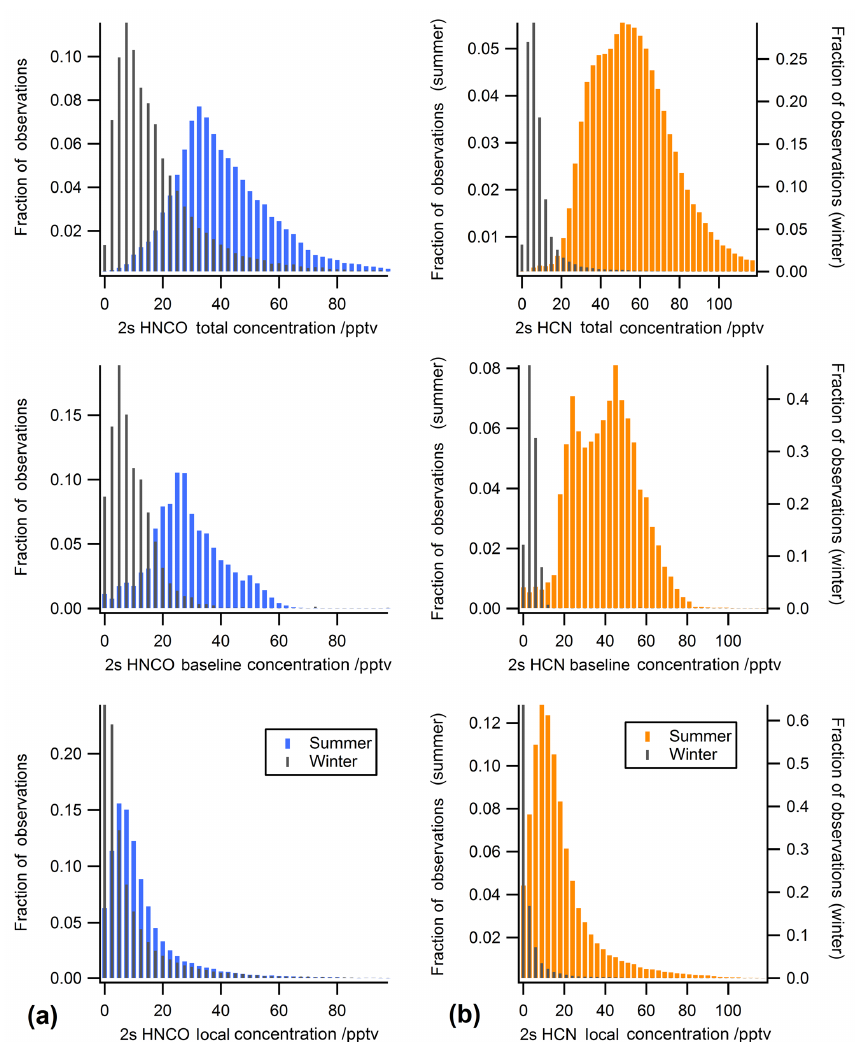
Figure 1. Distribution of ambient mixing ratios for (a) HNCO and (b) HCN. Top panel: total concentration. Middle panel: background (BKG) concentration. Bottom panel: background-corrected (LOCAL) concentration. Summer campaign (July 2015) shown as colored bars; winter campaign (January 2016) shown as grey